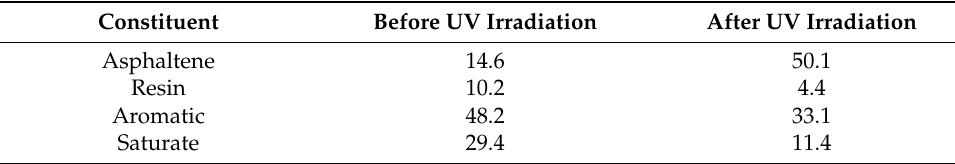
Table 9. SARA analysis result of asphalt.